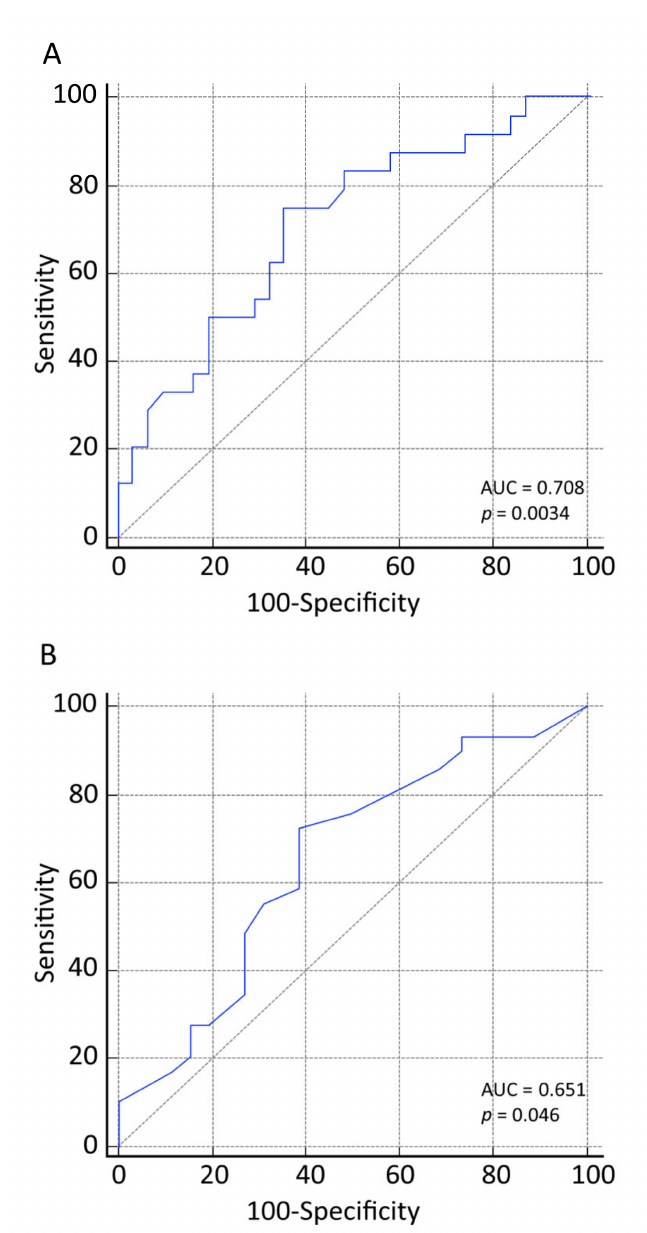
Figure 6. Diagnostic performance of mycophenolate mofetil (MMF) initial daily dose ( A ) and first mycophenolic acid (MPA) area under the curve (AUC) 0–12 ( B ) in predicting the age at